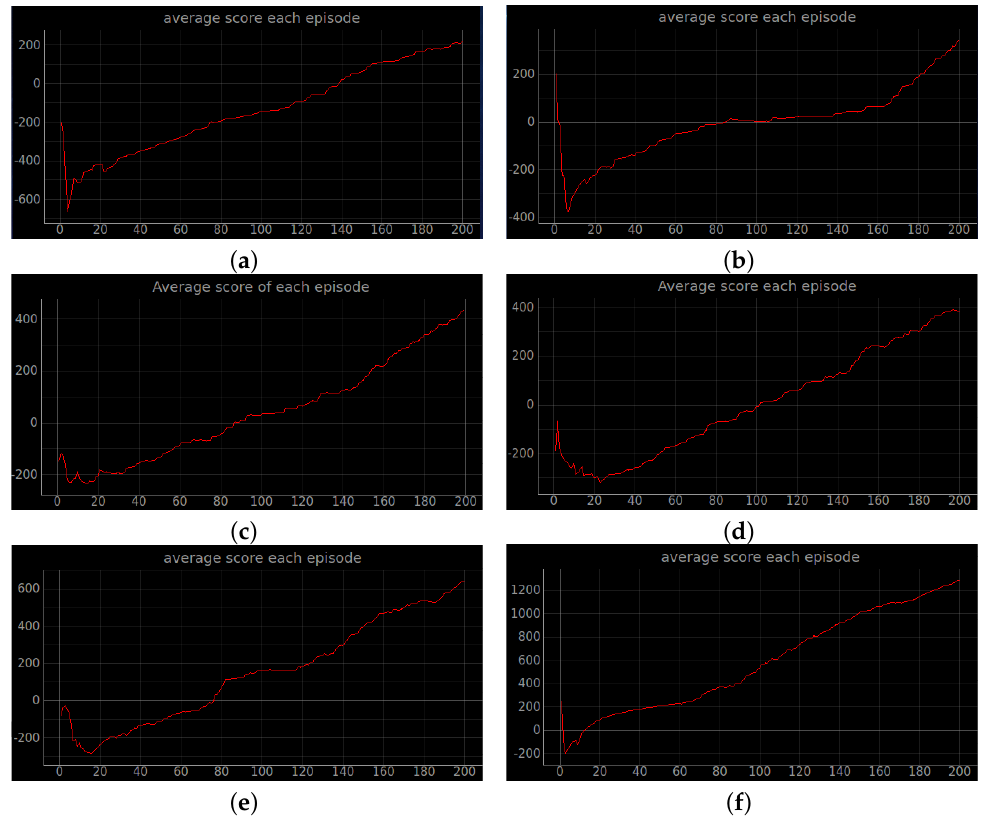
Figure 9. Average total reward curve per episode for stage 2. The increasing mean of the total rewards obtained from the environment per episode interaction indicates that the agent learns effective strategies. ( a ) Original DQN; ( b ) Double DQN; ( c ) Dueling DQN; ( d ) D3QN; ( e ) ND3QN; ( f ) RND3QN. Table 4. Average number of successful